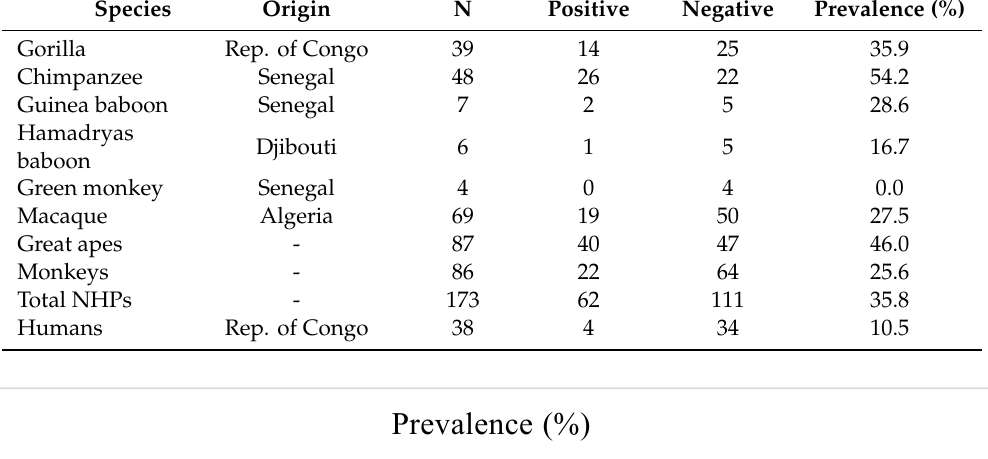
gorilla and human samples simultaneously, AdVs were more frequent in gorillas (35.9%) than humans Table 2. Prevalence of adenoviruses in African humans and non-human primates (NHPs).